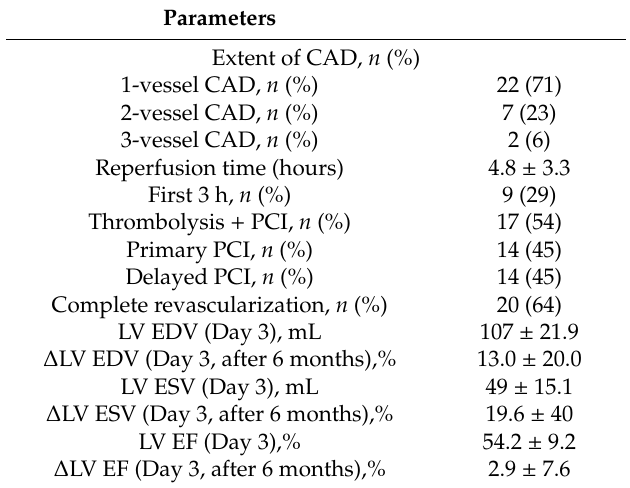
Table 2. Examination data for patients involved in the study ( n = 31)